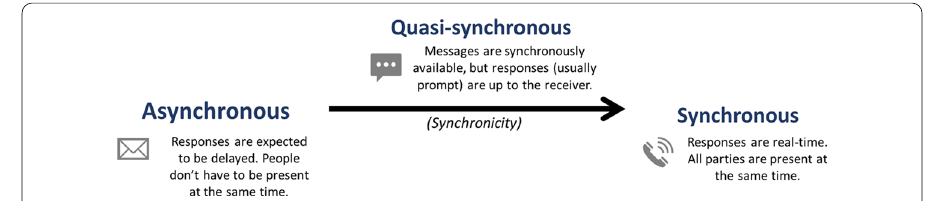
Fig. 1 The differences between asynchronous, synchronous, and quasi-synchronous